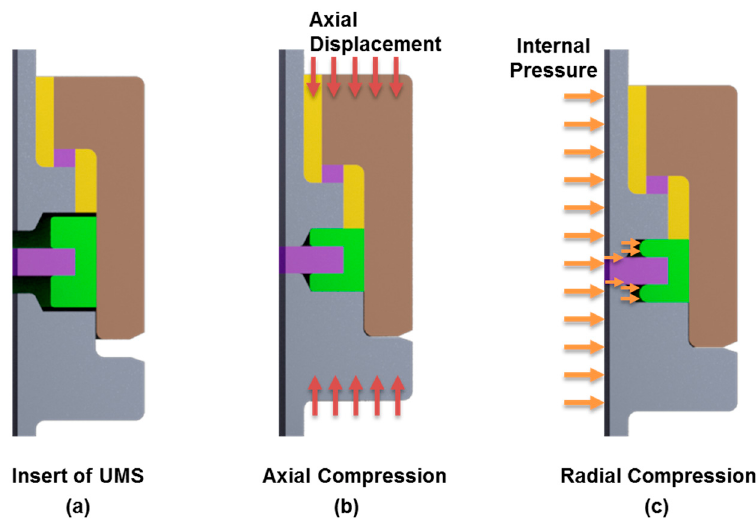
Figure 3. U-shaped sealing assembly process: ( a ) insertion of UMS; ( b ) axial compression due to displacement in assembly; and ( c ) radial compression due to internal pressure in operation.